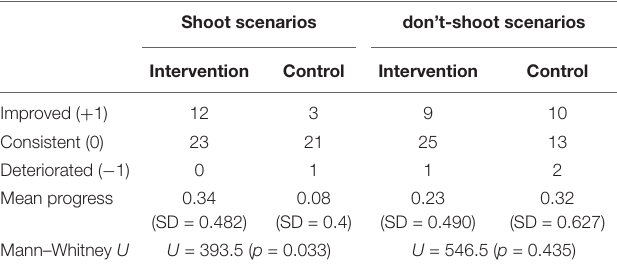
TABLE 4 | Overview of the decision progress from pre- to posttest in the intervention and control group ( N = 60). Shoot scenarios